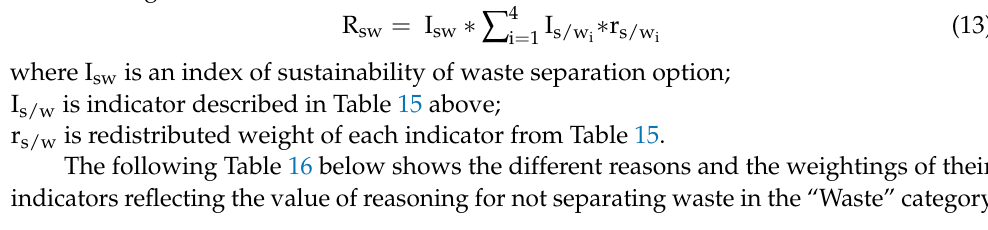
Table 16. Reasoning indicators for not separating waste.